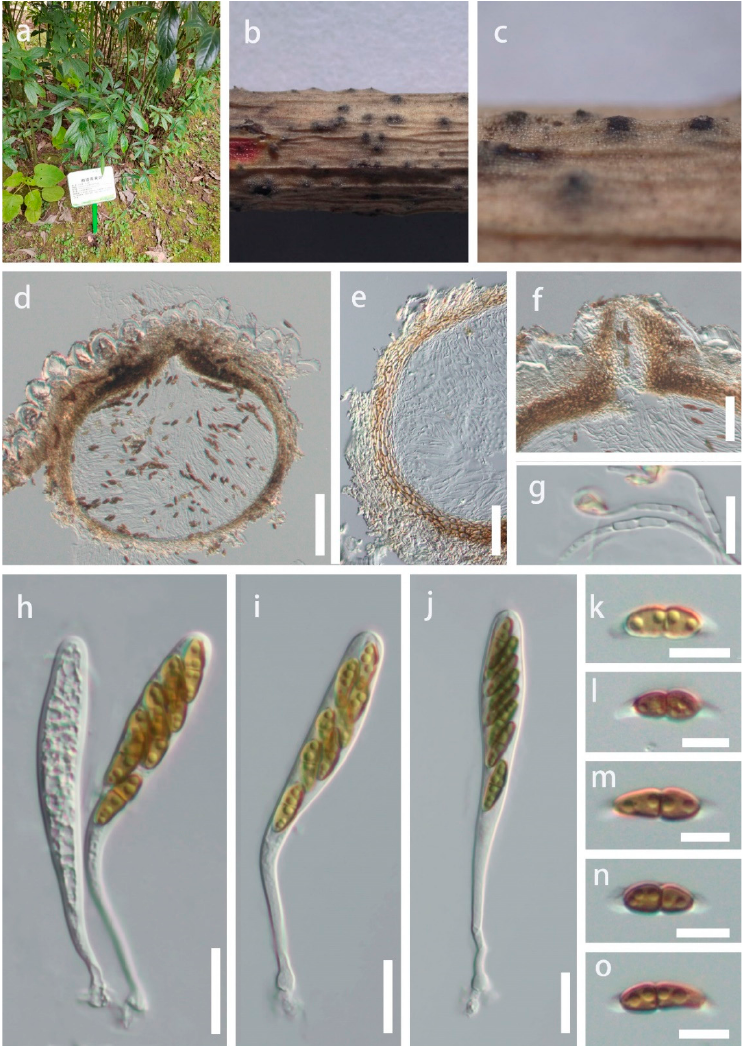
Figure 3. Montagnula guiyangensis (HKAS 124556, holotype). ( a ) Host, ( b , c ) Appearance of ascomata on the substrate, ( d ) Section through ascomata, ( e ) Peridium, ( g ) Trabeculate